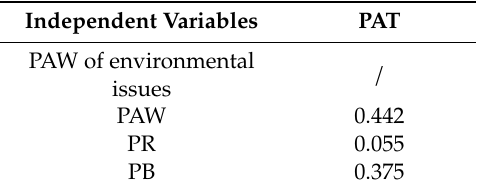
Table 10. B-values of independent variables of multiple regression